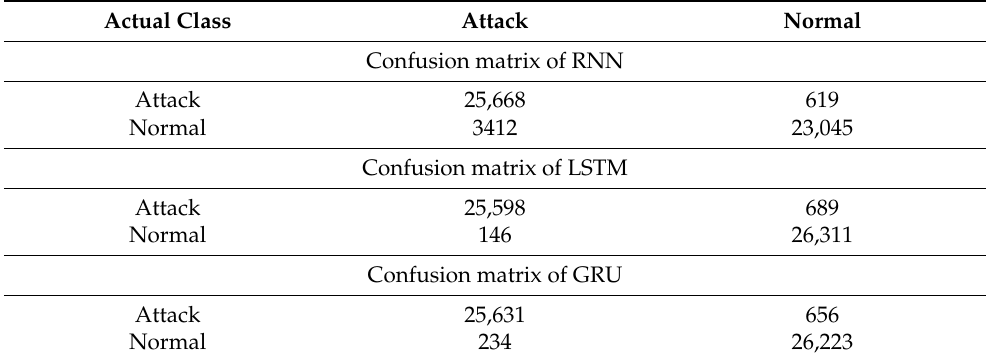
Table 9. Confusion matrix of RNN, LSTM, and GRU.